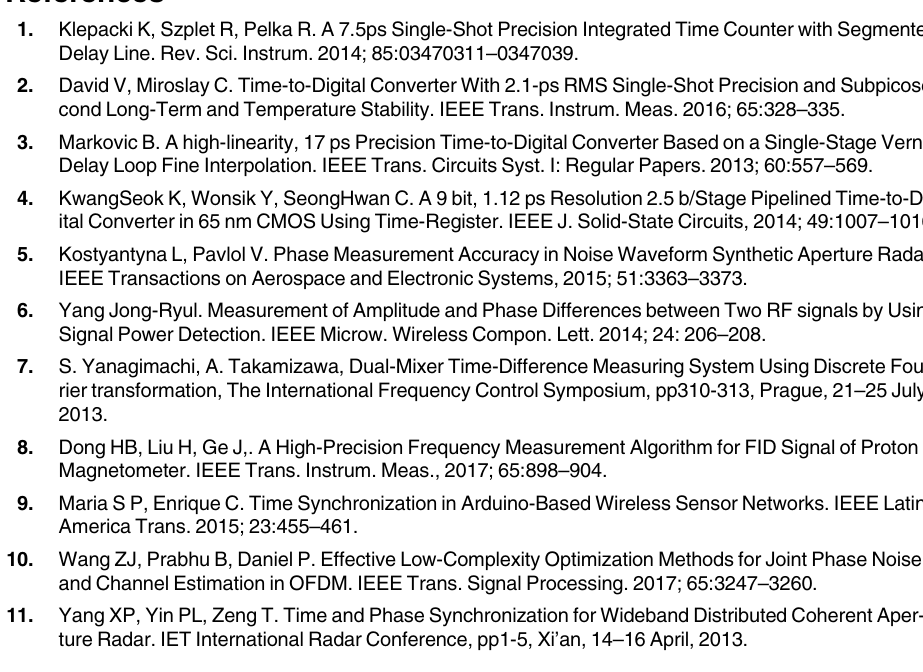
S2 Table. Frequency synchronization detection results with different sources.